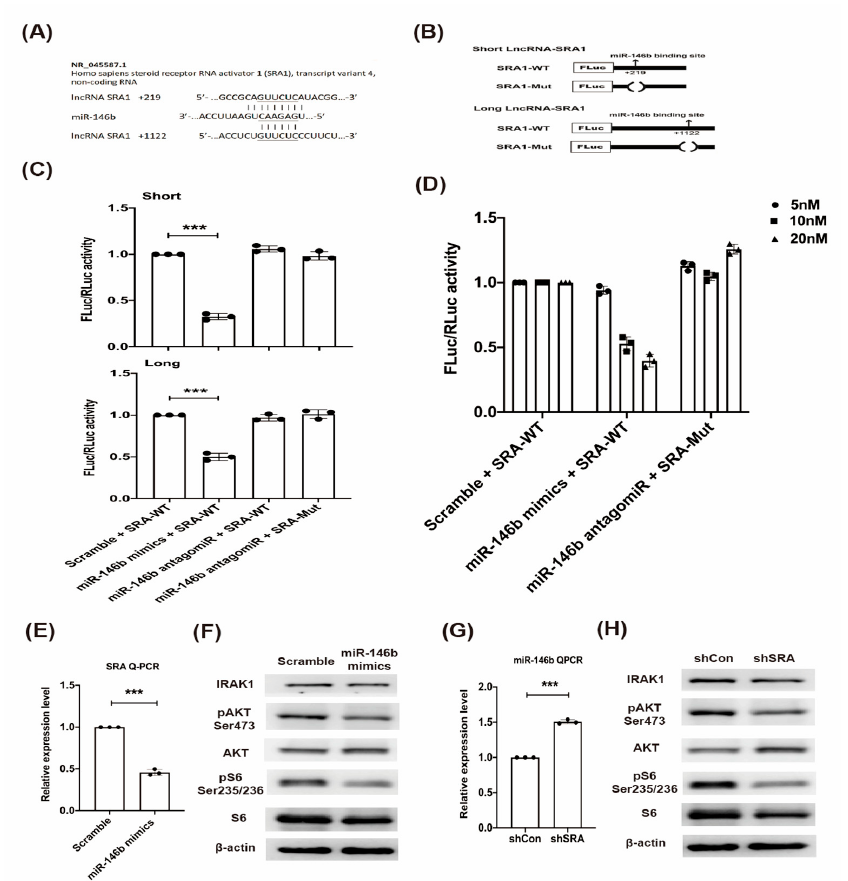
Figure 2. LncRNA SRA is direct target of miR-146b and regulates interleukin-1 receptor-associated kinase 1 (IRAK1)/protein kinase B (AKT)/ribosomal protein S6 kinase 1 (S6K1) signaling. ( A ) Two putative miR-146b miRNA response elements (MREs) (seed locations 219 and 1122) were predicted in the 3 ′ -untranslated regions (UTRs) of lncRNA SRA. ( B ) The short and long lncRNA SRA sequences (SRA-WT (wild type)), in parallel with mutant derivatives lacking MREs (SRA-Mut), were